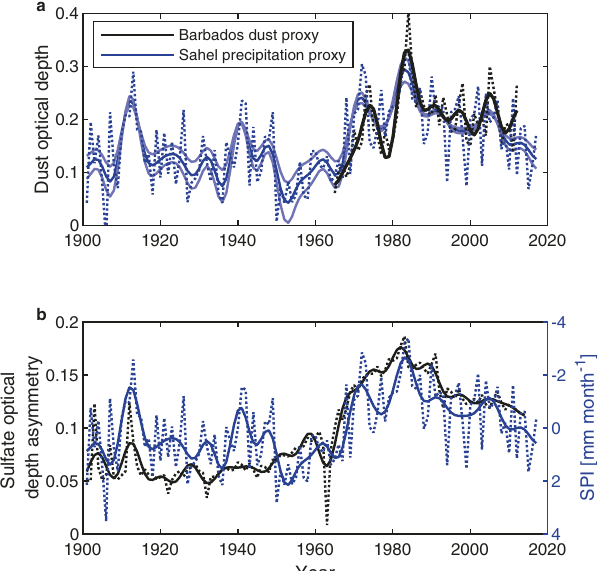
Fig. 2 | Dust optical depth proxies and sulfate aerosol asymmetry. a Barbados summer dust measurements rescaled by satellite measurements of main develop- mentregiondustopticaldepthduringthe1980s(black),maindevelopmentregion dust optical depth reconstruction based on the Sahel precipitation index (SPI) proxy(darkblue)and 95%con fi denceintervalon the SPI proxy (pale blue). Dotted lines are not fi ltered, and full lines are low-pass fi ltered. b Low-pass fi ltered anthropogenic and volcanic sulfate aerosol optical depth asymmetry (black), and SPI (blue). The y -axis for the precipitation index is reversed so that peaks indicate dry years. Dotted lines are not fi ltered, and full lines are low-pass fi shown (light blue), and on average, during the 1970s and 1980s, dust